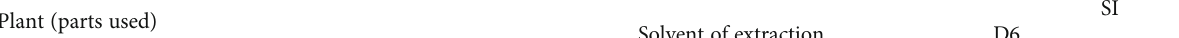
Table 4: Selectivity indices (SI) of the selected plant part(s) assayed against CQ-sensitive (D6) and CQ-resistant (W2) strains of P. falciparum. Plant (parts used) Terminalia brownii Fresen.